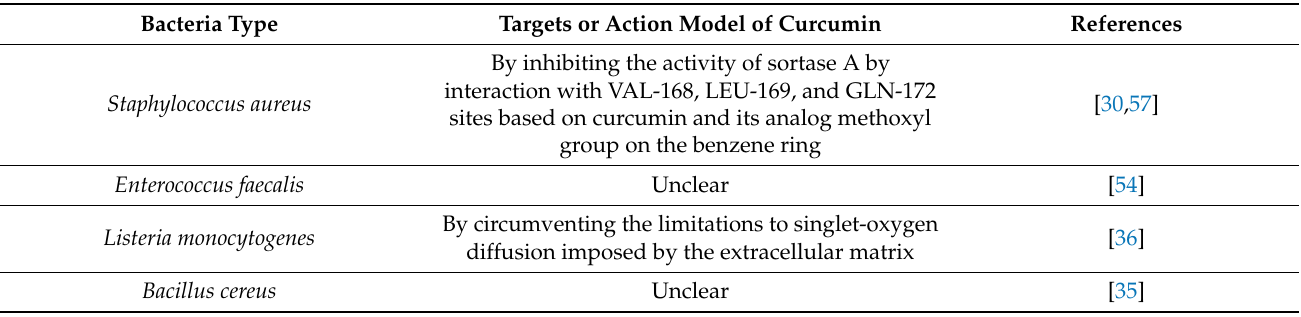
Table 2. Targets or action model of curcumin in the inhibition of biofilm in various bacteria. Bacteria